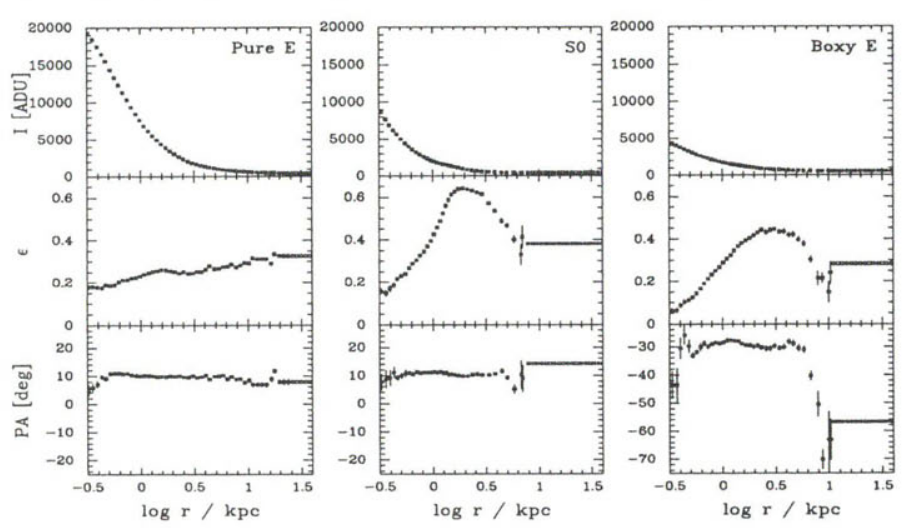
Fig. 4. Radial profiles of intensity, ellipticity and position angle for the three example